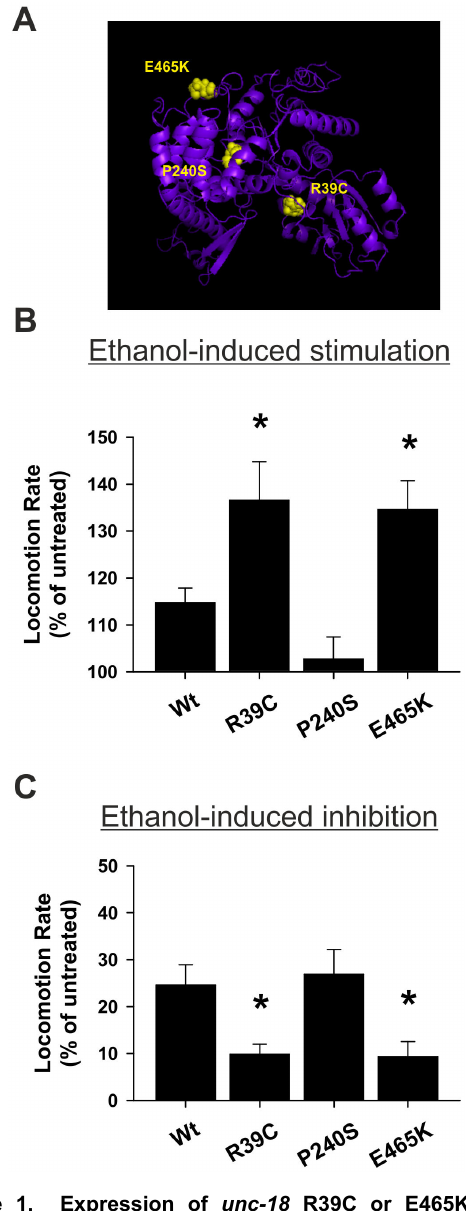
Figure 1. Expression of unc-18 R39C or E465K point mutations enhances acute alcohol sensitivity. (A) Location of the three investigated point mutations of unc-18 (R39C, E465K and P240S) in a predicted model of UNC-18 structure. Null unc-18 ( e81 ) worms were rescued transgenically with either wild-type (Wt) unc-18 or unc-18 with the indicated point mutations. In comparison to Wt unc-18 , both the R39C and E465K point mutations increased acute sensitivity to ethanol at (B) stimulatory levels (21 mM) and (C) depressive levels (400 mM) of external ethanol. For (A) significance was assessed by one-way analysis of variance with post-hoc comparisons; *P<0.05; N = 28 (Wt), 20 (R39C), 22 (P240S) and 20 (E465K). For (B) significance was assessed by Kruskal-Wallis one-way analysis of variance with post-hoc comparisons; *P<0.05; N = 29 (Wt), 40 (R39C), 20 (P240S), 18 (E465K). doi: